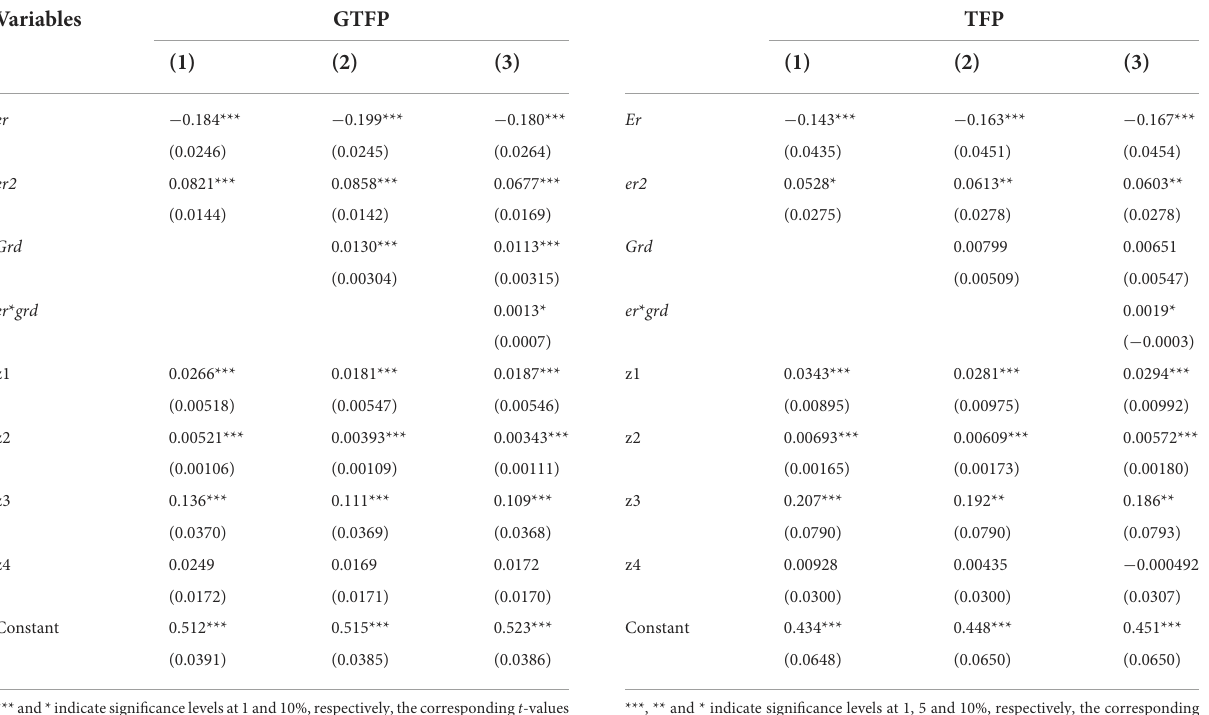
TABLE 5 Regression results of the Tobit model. TABLE 6 Regression